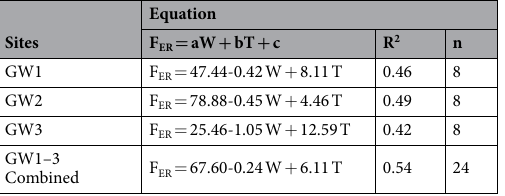
Table 3. Correlations of summertime soil respiration rates and soil moisture, 0–10 cm mean soil temperature at the tundra sites of the upland tundra. Note: Only the equations and R 2 values significant at p < 0.05 are